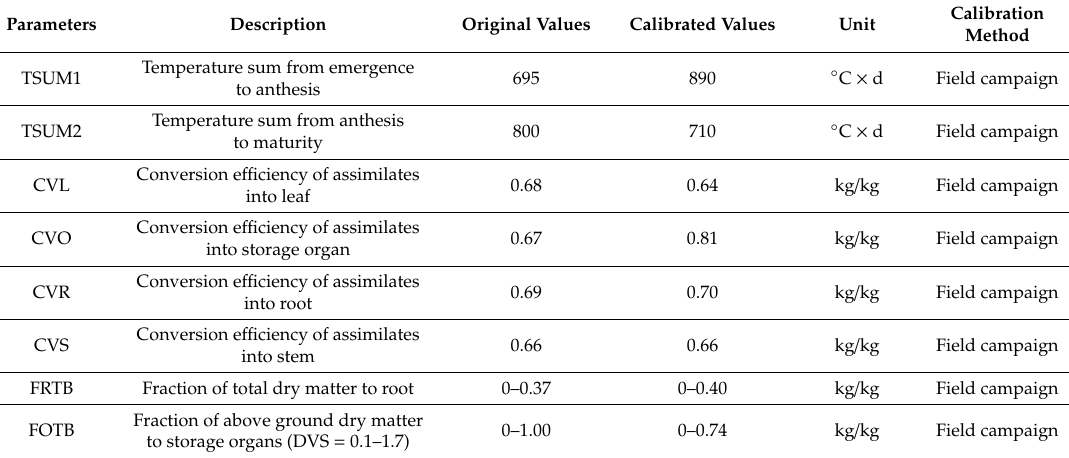
Table 3. Core parameter calibration results of the WOFOST